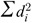
Boxplots representing four measures of simulation data with an increase in d.
A. Variation of distributions due to increase in sample sizes (Case I). B. Variation of distributions due to bias of sample sizes (Case II). For both cases, the x-axis denotes the distance d, and the y-axis and denotes the following measures: -log10
Pvalue for chi-square test and ANOVA F-test; Weir and Cockerham’s Fst estimates for Fst; ∑​di2 for NSCM.